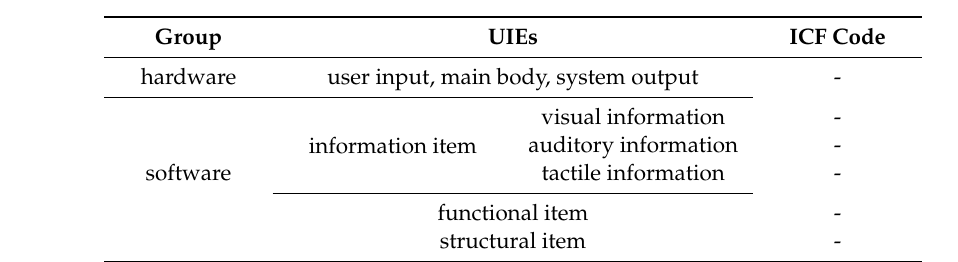
Table 4. UIEs of IT devices.